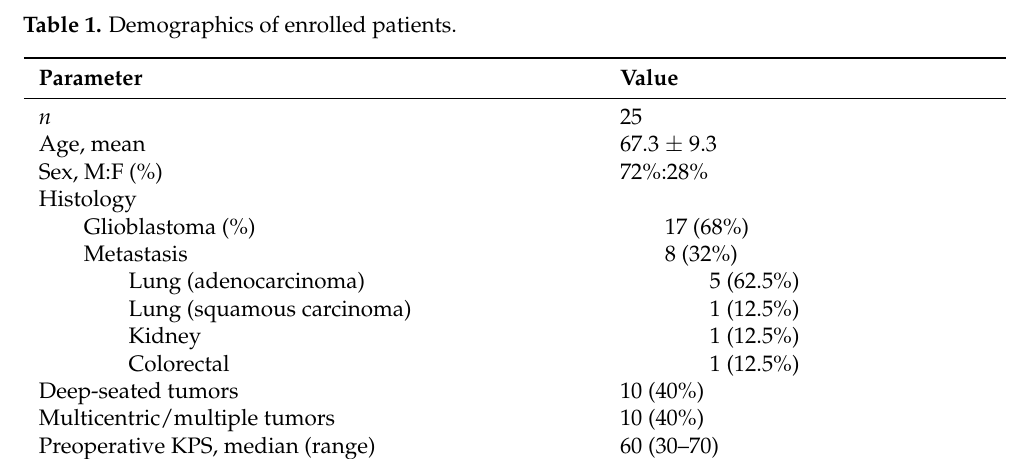
Table 2. Clinical and surgical